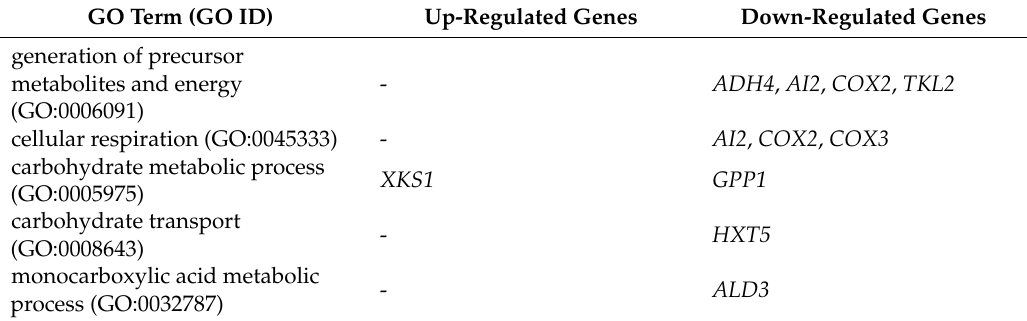
Table 3. Hxk2p S14A -regulated genes that were annotated to GO terms related to carbohydrate metabolism in the ‘Biological Process’ GO